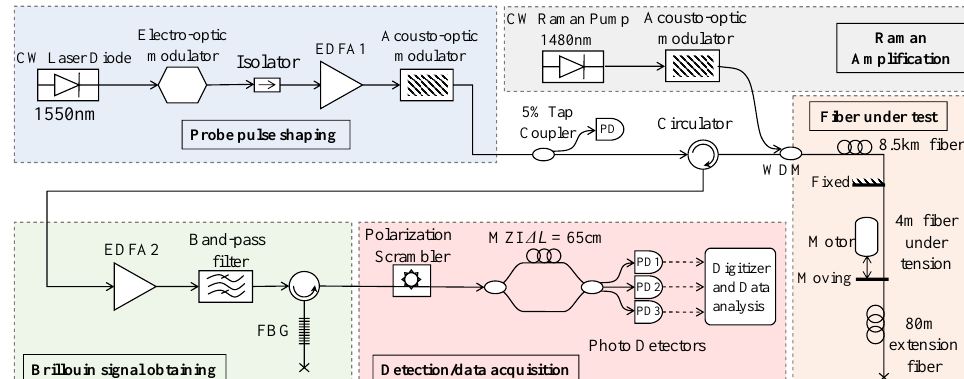
Figure 4. Experimental setup consisting of five sections: probe pulse shaping, fiber under test, scattered Brillouin signal collection, detection/data acquisition and Raman amplification (EDFA: Erbium-doped fiber amplifier, FBG: Fiber Bragg Grating, MZI: Mach Zehnder Interferometer, PD: Photodetector, EOM: Electro-optic modulator, and WDM: Wavelength Division